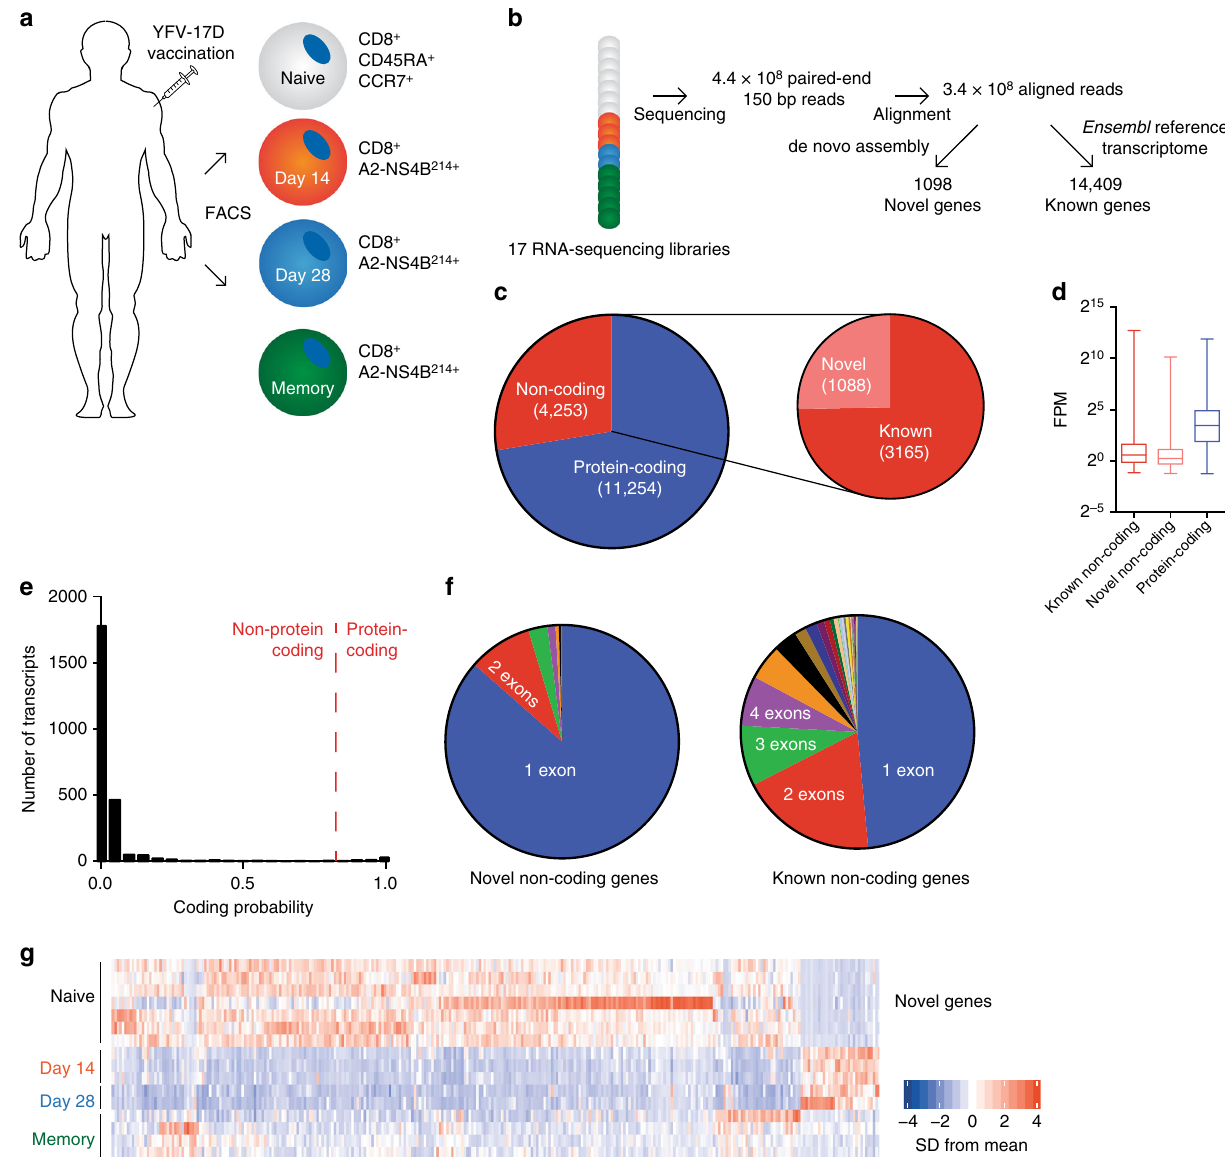
Fig. 4 Transcriptomic analysis of antigen-speci fi c human CD8 + T cells during acute infection. a Antigen-speci fi c CD8 + T cells were isolated from healthy volunteers at indicated time points following administration of the live attenuated yellow fever-17D (YF-17D) vaccine 5 . b From these cell populations, RNA- sequencing libraries were generated and sequenced. Resulting sequences were aligned and analyzed for the expression of both reference and novel genes. c Types of genes expressed in human antigen-speci fi c CD8 + T cells. d Average expression levels of types of genes from ( c ). e , f Protein-coding potential and exonic structure of the novel genes detected by de novo transcriptome assembly. g Expression of differentially expressed novel genes across all samples. In panel ( d ), bars indicate minimum and maximum values and box indicates 25th percentile, median, and 75th percentile. FPM, fragments per million; SD, standard